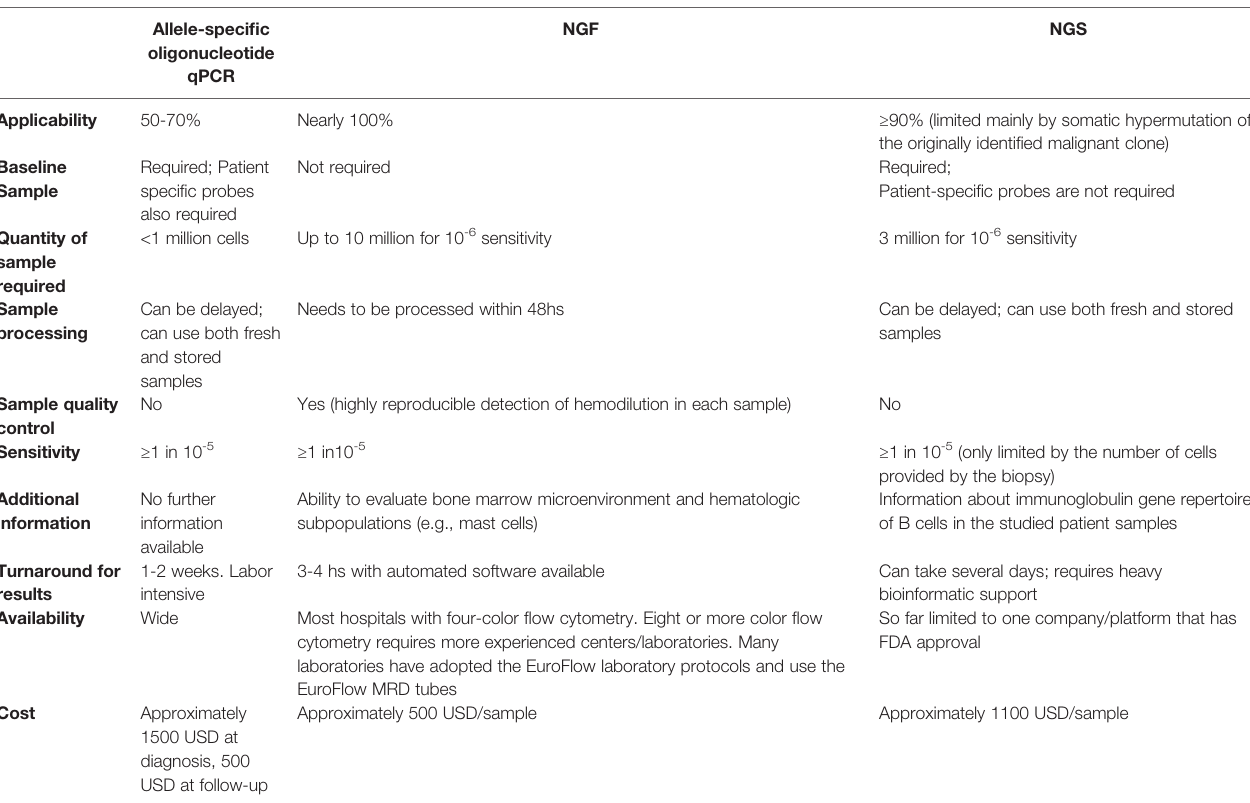
TABLE 2 | MRD methods used for bone marrow biopsy assessment (10,